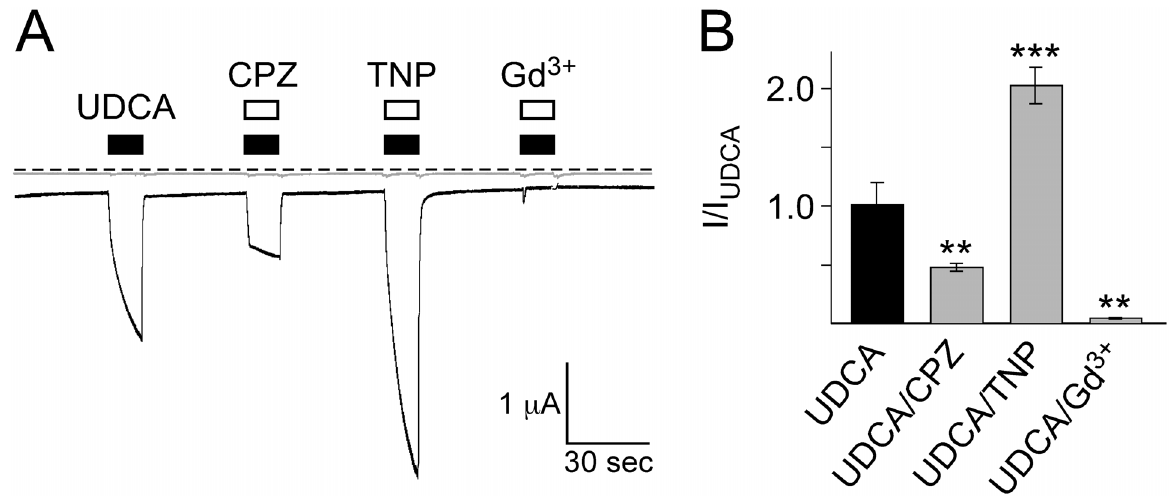
Figure 1. BASIC responses to bile acid are modulated by the membrane active substances chlorpromazine, trinitrophenol and Gd 3 + . A) Representative current traces of an oocyte expressing BASIC (black trace) and a water-injected control oocyte (grey trace). Application of 2 mM UDCA induced a typical BASIC current. Co-application of 0.5 mM CPZ strongly decreased the UDCA-dependent current while co-application of 2 mM TNP strongly increased the current amplitude. The UDCA-dependent current was completely abolished by 100 m M Gd 3 + . Dotted line represents the 0 current level. B) Quantitative comparison of current amplitudes induced by UDCA alone or together with 0.5 mM CPZ, 2 mM TNP or 100 m M Gd 3 + . Currents were normalized to the current induced by UDCA alone, which had an amplitude of 1.1 6 0.2 m A ( n =10). Error bars represent SEM. Statistical significances were tested using one-way ANOVA followed by Tukey’s multiple comparison test versus UDCA, **p , 0.01, ***p , 0.001.